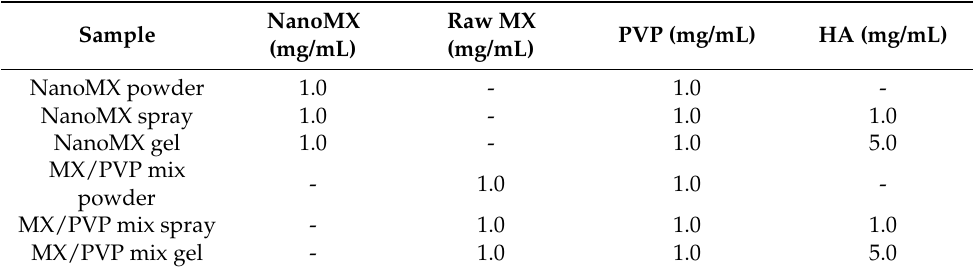
Table 1. Compositions of the intranasal